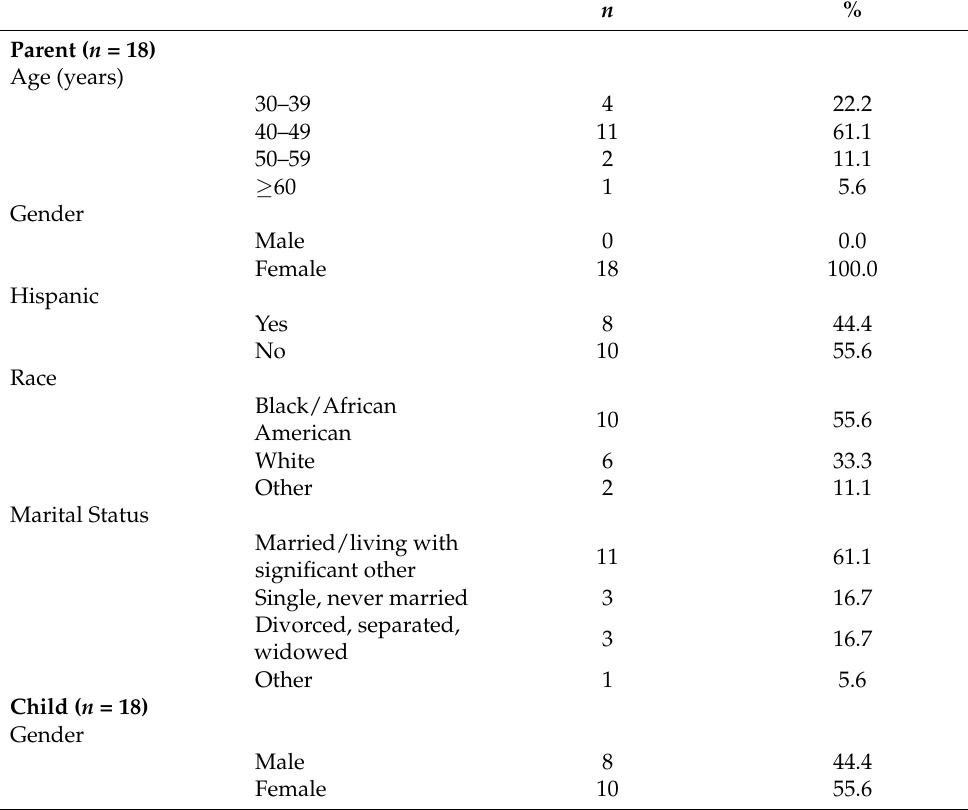
Table 1. Family/household